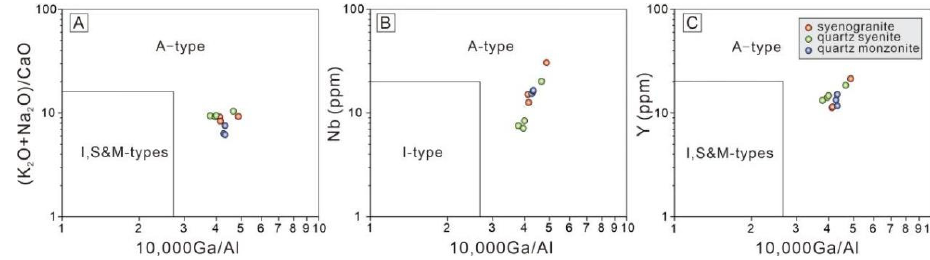
Figure 14. ( A – C ) Rock ‐ type discrimination diagrams [46]. In summary, the rollback of the subducting Izanagi plate during the Early Creta ‐ ceous triggered the asthenosphere upwelling and lithospheric thinning and partial melting of the lithospheric mantle [76–78]. The lithospheric mantle ‐ derived magma was emplaced at a shallower crustal depth and contaminated by crustal material during as ‐